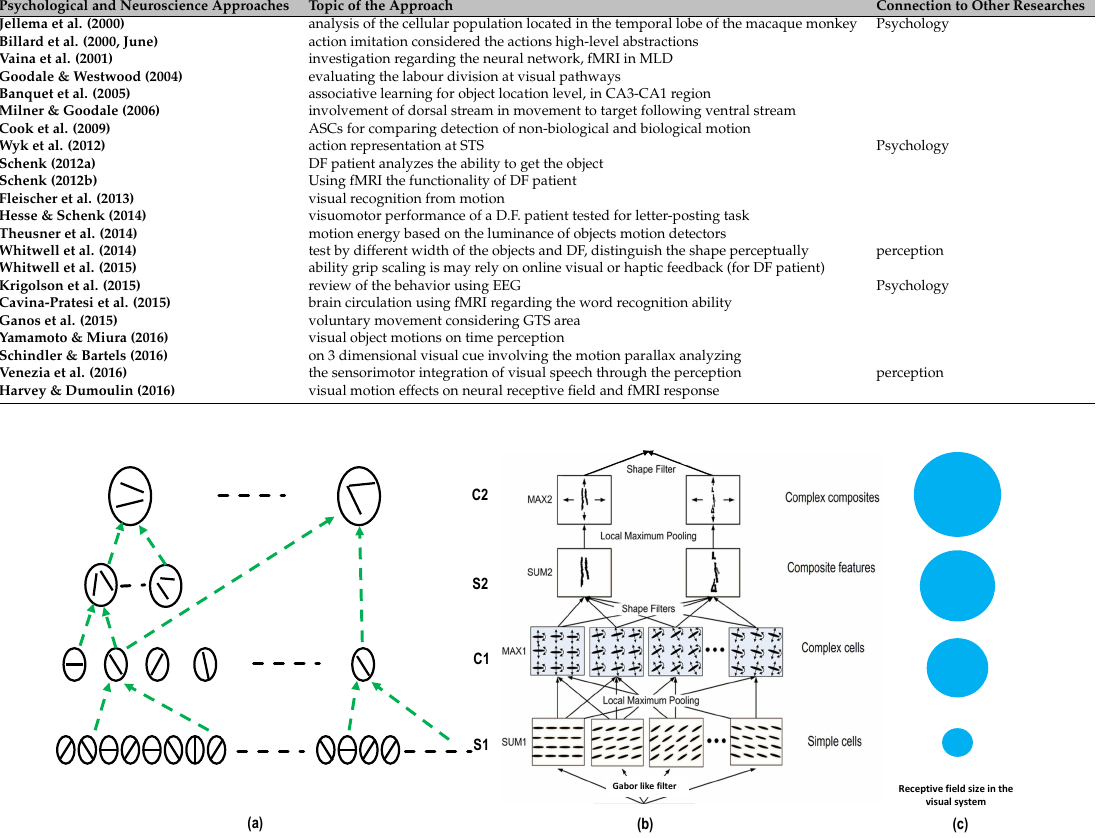
Table 2. The Knowledge based modeling approaches presented with their contribution in the field.